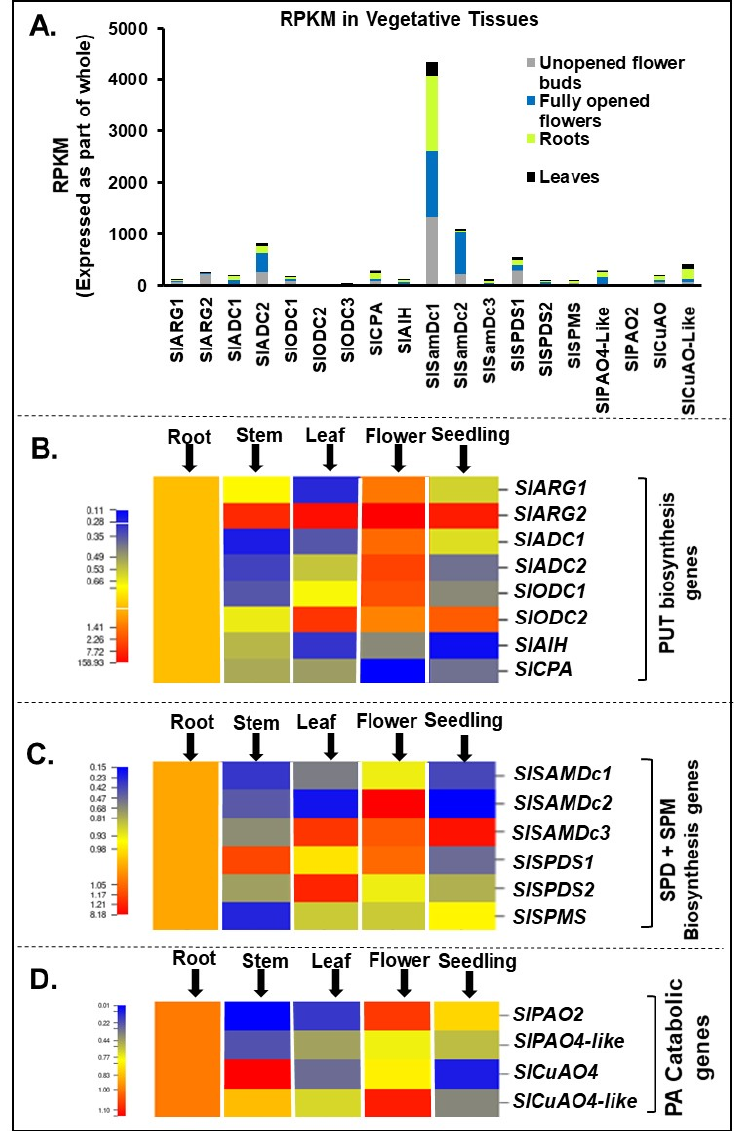
Figure 1. Spatiotemporal gene expression of tomato ( Solanum lycopersicum L.) polyamines (PA) metabolic pathway genes. ( A ) Global transcriptome analysis of tomato vegetative tissues (flower-buds, open flower, leaf and roots) reveals di ff erential abundance of polyamine biosynthesis genes SlARG1, 2 , SlADC1, 2 SlODC1, 2, SlAIH and SlCPA and catabolic enzymes encoding genes SlPAO2 and SlPAO4-Like; SlCuAO and SlCuAO4-like . ( B ) qRT-PCR based gene expression analysis of tomato vegetative tissues (root, stem, leaf, open flower and seedling tissues) reveals di ff erential abundance of putrescine (PUT) biosynthesis genes SlARG1, 2 , SlADC1, 2 SlODC1, 2, SlAIH and SlCPA . ( C ) Spermidine (SPD) and spermine (SPM) biosynthesis genes SlSAMDc1, 2, 3, SlSPDS1, 2 and SlSPMS . ( D ) PA catabolic pathway genes SlPAO2 and SlPAO4-Like; SlCuAO and SlCuAO4-like . A minimum of three plants were taken for collection of vegetative tissues for each biological replicate and mean data points and standard error were derived from three biological replicates. Statistical significance ( p -value) was derived using Graph prism pad program via Tukey test / t-test. SlUBI3 and SlTIP41 were used as reference